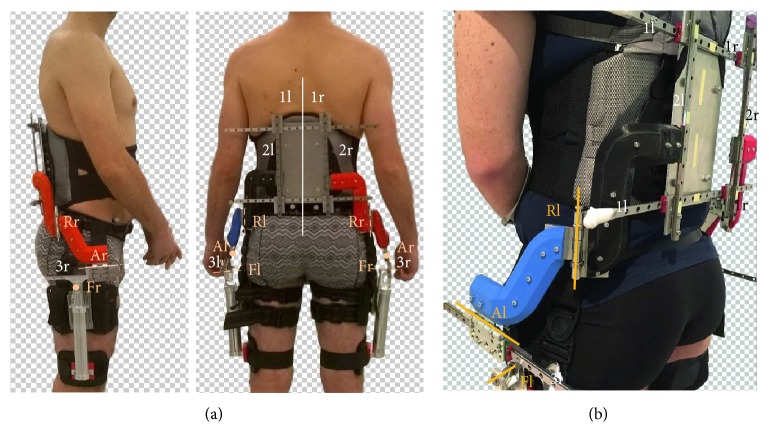
Bilateral, full-DOF, misalignment-compensating hip exoskeleton. Linear sliders are numbered in white, and rotational joints are marked and named in orange. The added suffix l or r indicates the use of each element by the left of right hip. (a) Overall side and back view. (b) Close-up of the left side of the prototype.